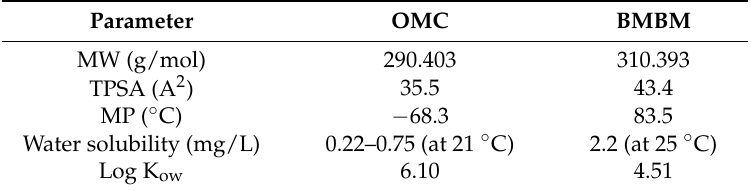
Table 5. OMC and BMBM physicochemical properties: molecular weight (MW), topological polar surface area (TPSA), melting point (MP), water solubility and log partition coefficient octanol/water (Log K ow ). Data obtained from Pubchem, 2017 [46].